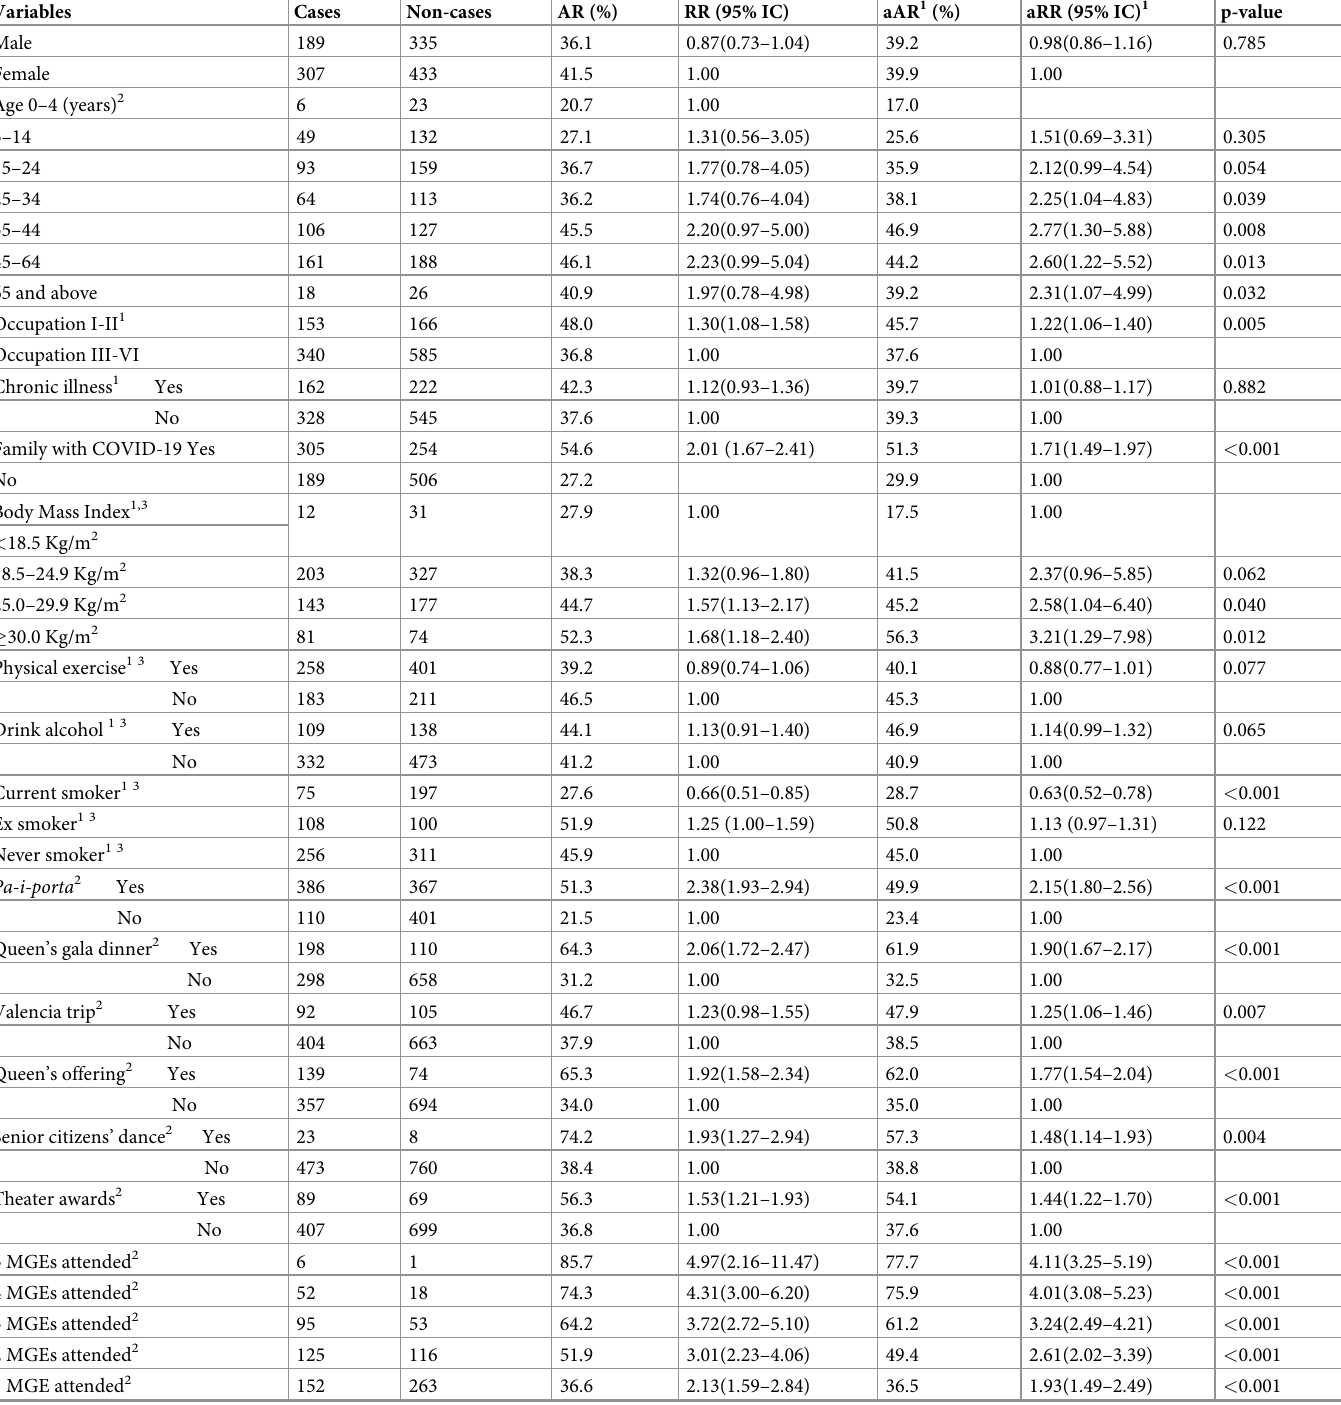
Table 4. Mass Gathering Event (MGE) attendance, Attack Rate (AR), adjusted AR (aAR), Relative Risk (RR), and adjusted (aRR). Confidence interval (CI). From March 6 to 31, 2020,